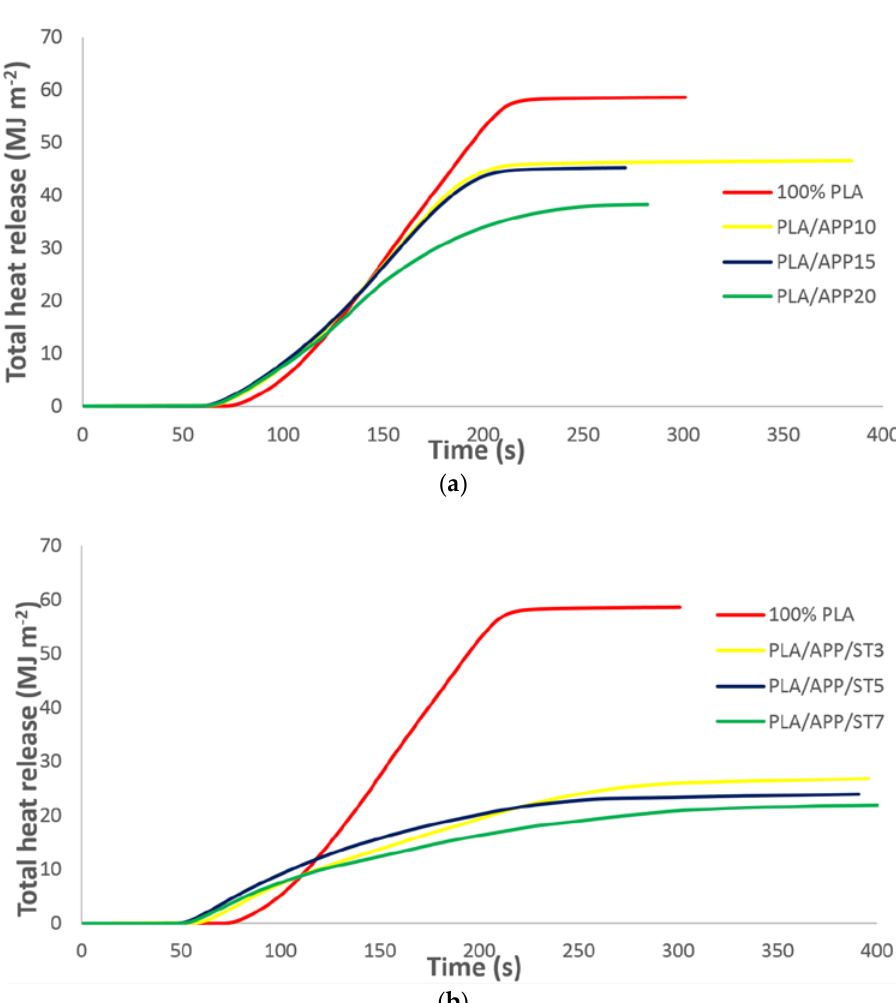
Figure 4. ( a ) Total heat release curves of pure PLA and PLA/APP composites. ( b ) Total heat release curves of pure PLA and PLA/APP/ST composites.